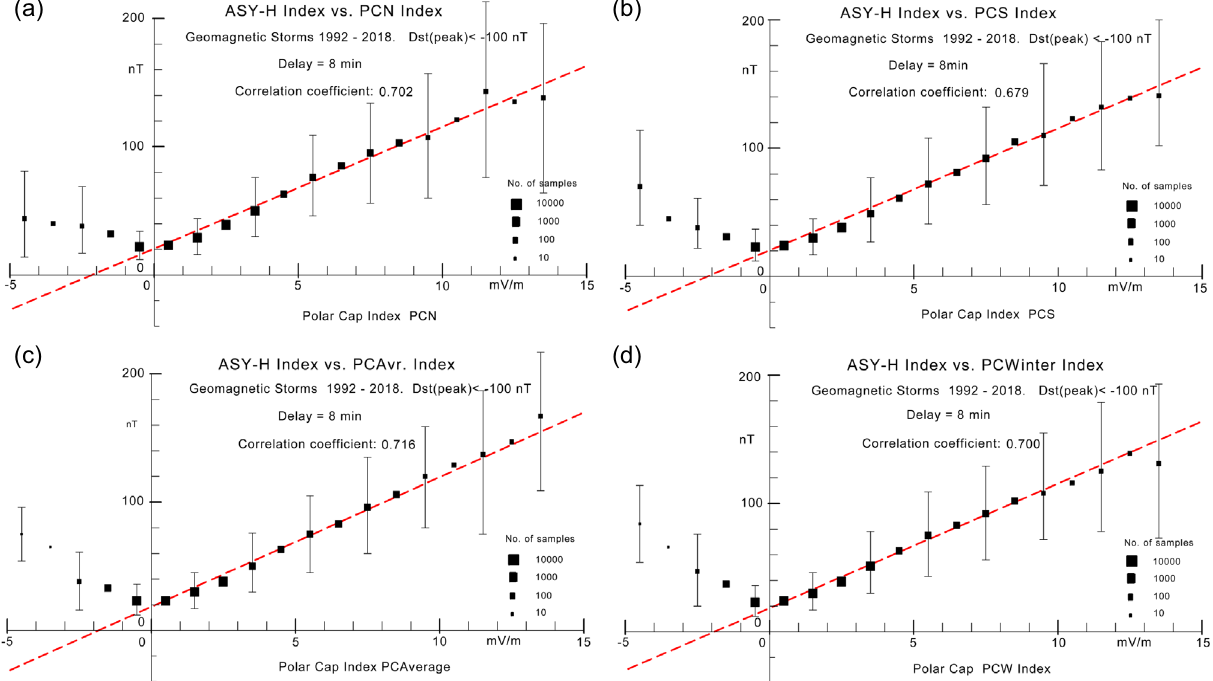
Fig. 10. Displays corresponding to Figure 9b for the relations between ASY-H and PC indices represented by (a) PCN, (b) PCS, (c) PCA (average of PCN and PCS), and (d) winter hemisphere PCW index. The red dashed lines are illustrative only and placed to fi t the positive PC index values. Note the upturns for negative PC index